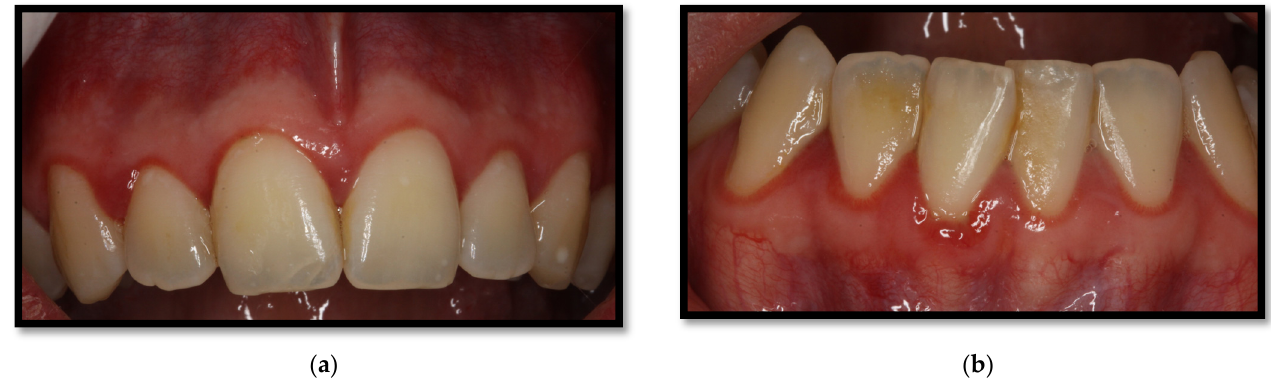
Figure 4. ( a ) Linear gingival erythema in the anterosuperior area ( b ) linear gingival erythema in the anteroinferior area.